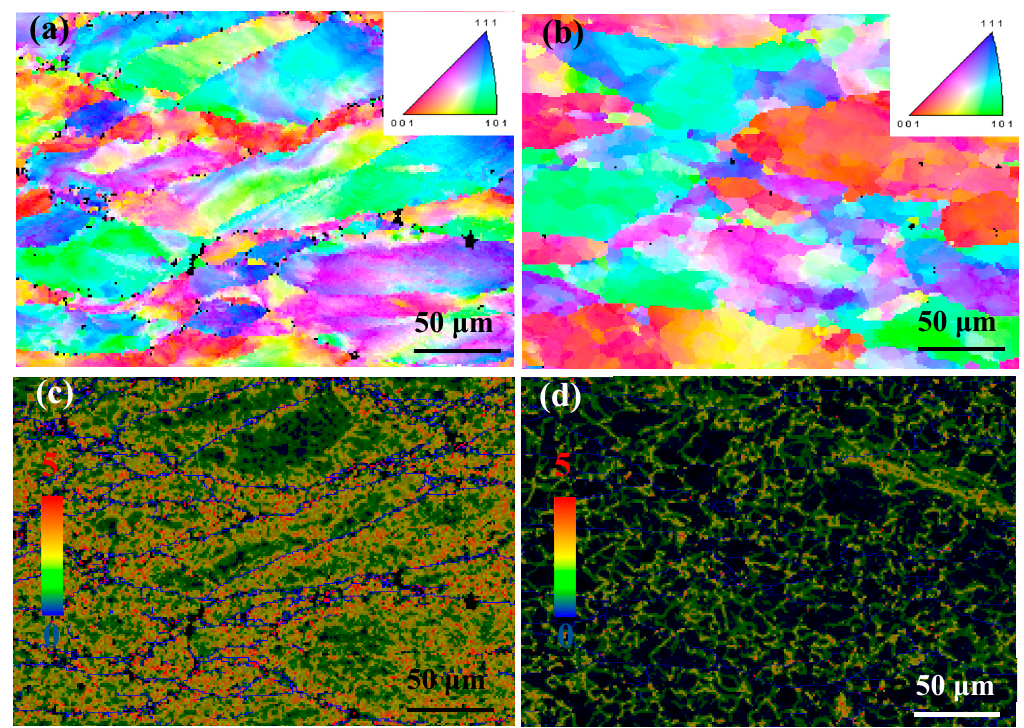
Figure 5. EBSD micrographs and Kernel Average Misorientation of the Cu-Ni-Co-Si-Cr-Ce alloy deformed at: ( a ) and ( c ) 600 °C and 0.001 s − 1 , ( b ) and ( d ) 900 °C and 0.001 s − 1 .